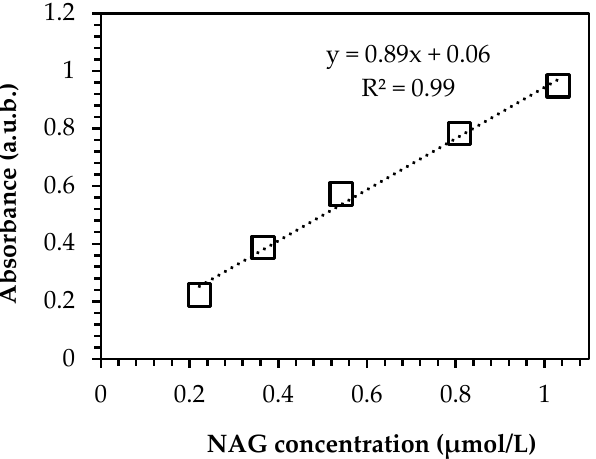
Figure A2. The ζ -potential (mV) distribution of ChNC at pH 8.